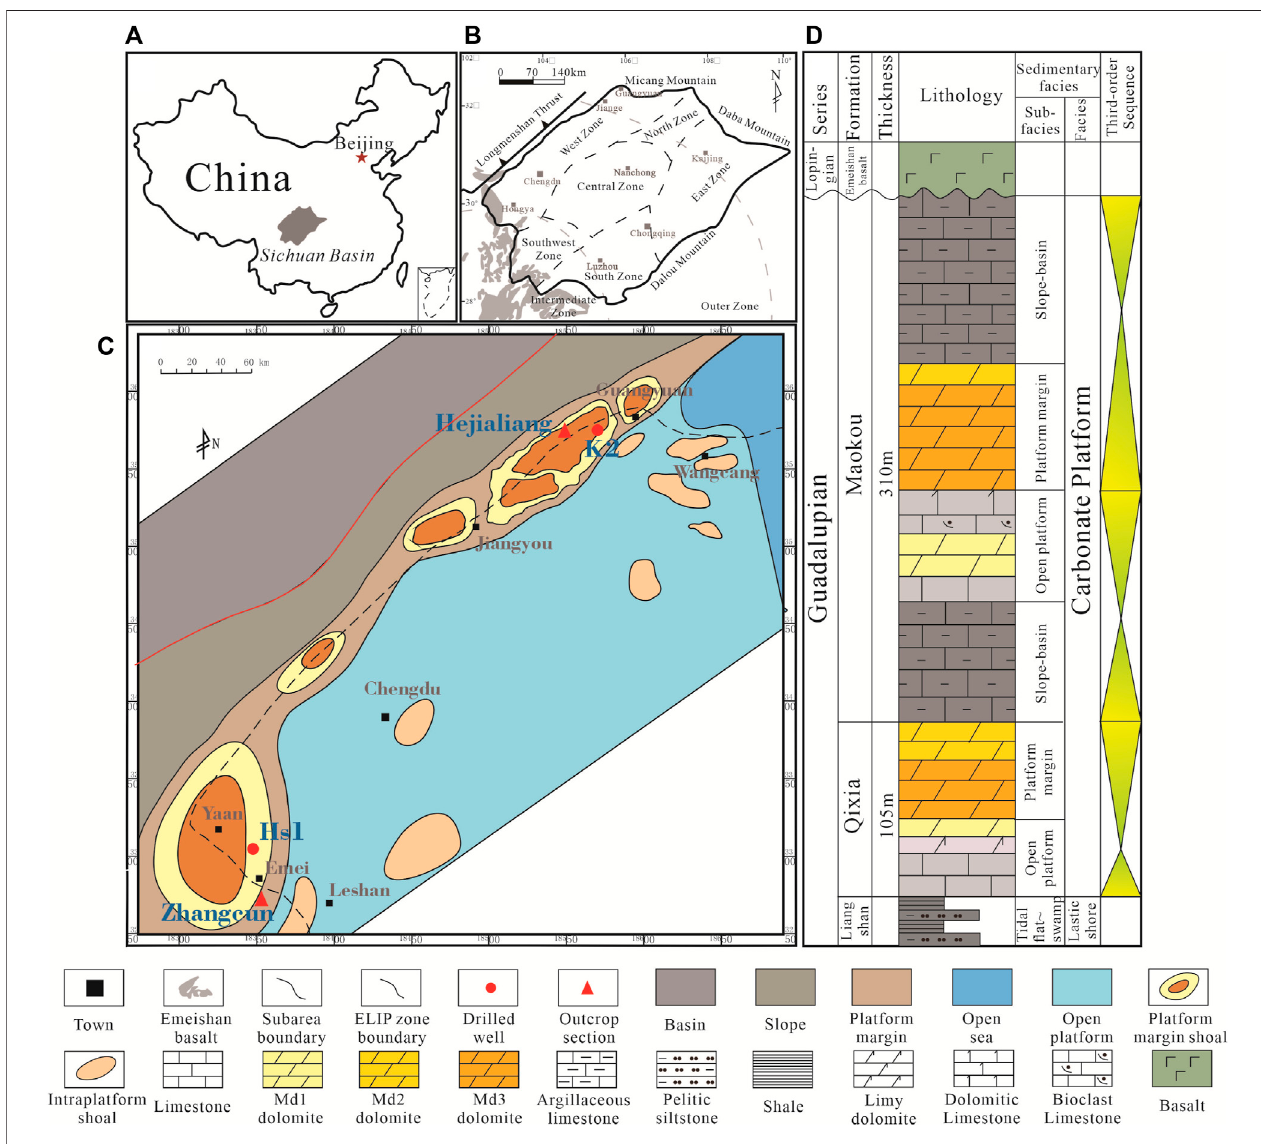
FIGURE1|(A) Simpli fi edlocationmapoftheSichuanBasininChina. (B) Distributionoftectoniczones,ELIPzones,andbasaltsintheSichuanBasin(modi fi edafter Huang et al., 2016; Dong et al., 2020). (C) Sedimentary map of the Middle Permian in the Western Sichuan Basin with the location of study outcrops and wells. (D) Generalized stratigraphic column of the Middle Permian (Guadalupian) succession in the Western Sichuan Basin (Zhou et al., 2016; Feng et al., 2021).